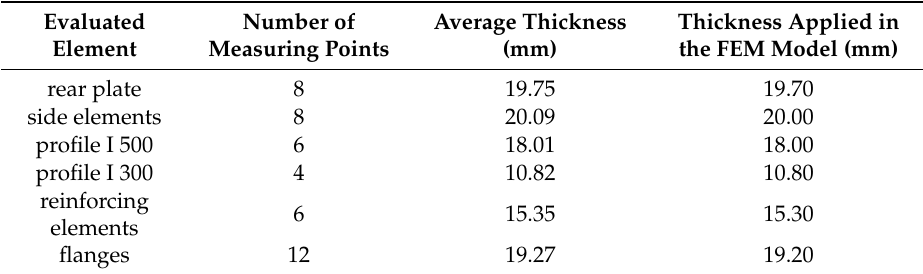
Table 6. Average thickness values of the load-bearing elements of the sluice gate.